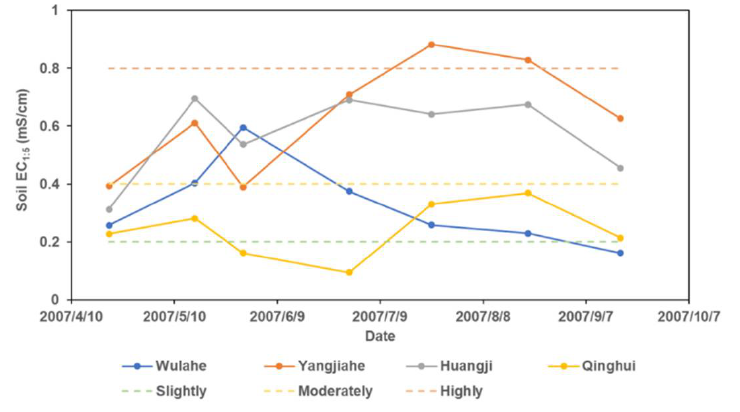
Figure 8. The soil EC1:5 (mS/cm) during the 2007 cropping season for the four